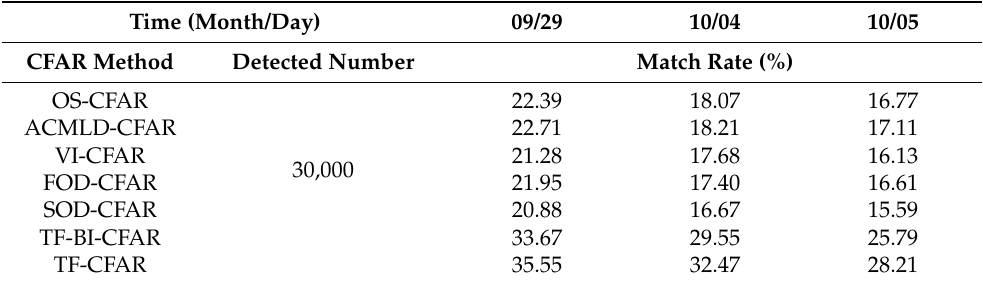
Table 4. Comparison of match rates by seven CFAR detectors under the same number of detected targets in three